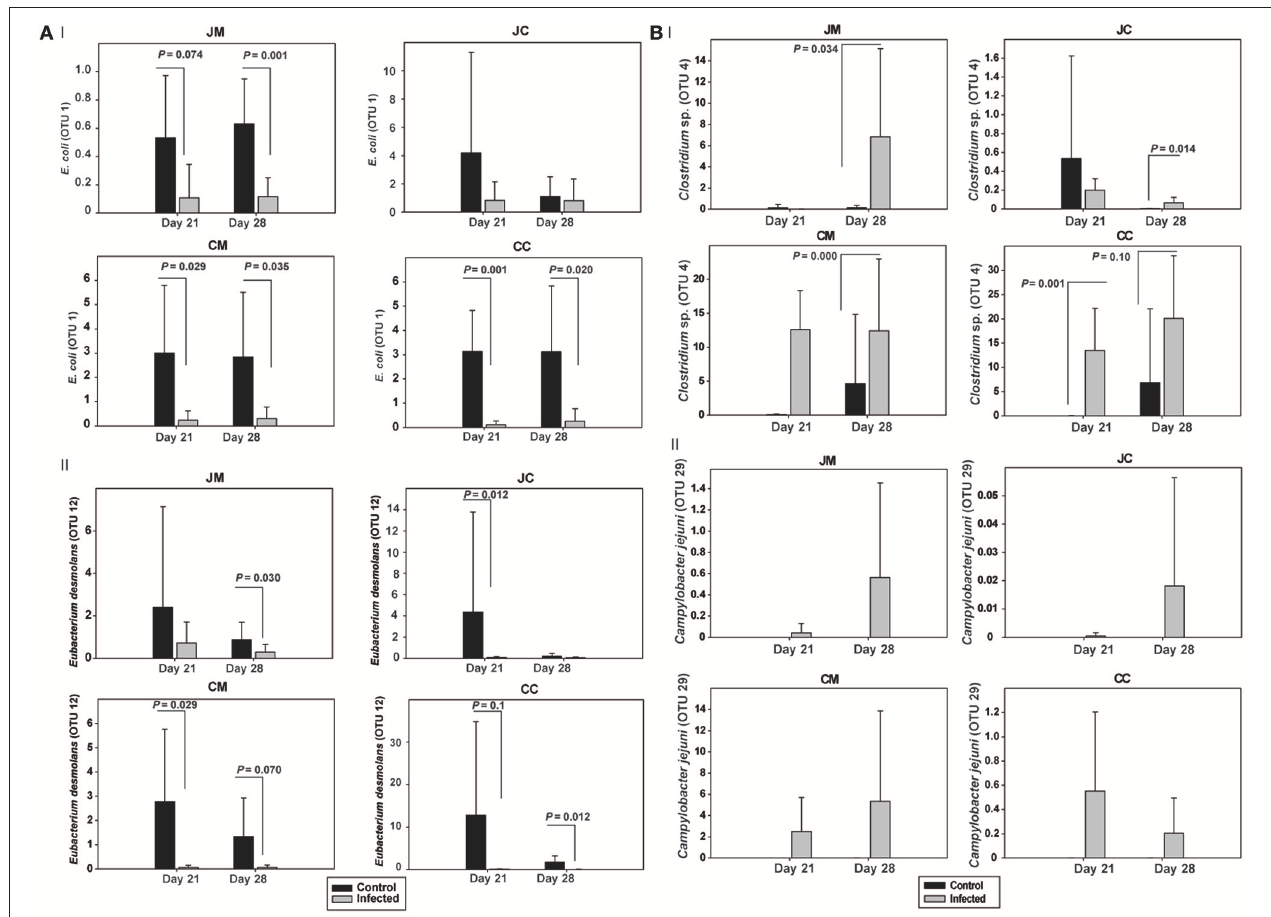
FIGURE 3 | Relative abundances (%) of the most relevant OTUs in the infected birds compared with the controls at the two sampling points post infection (A) OTUs 1 and 12, (B) OTUs 4 and 29. JM, jejunal mucosa; JC, jejunal content; CM, cecum mucosa; CC, cecum